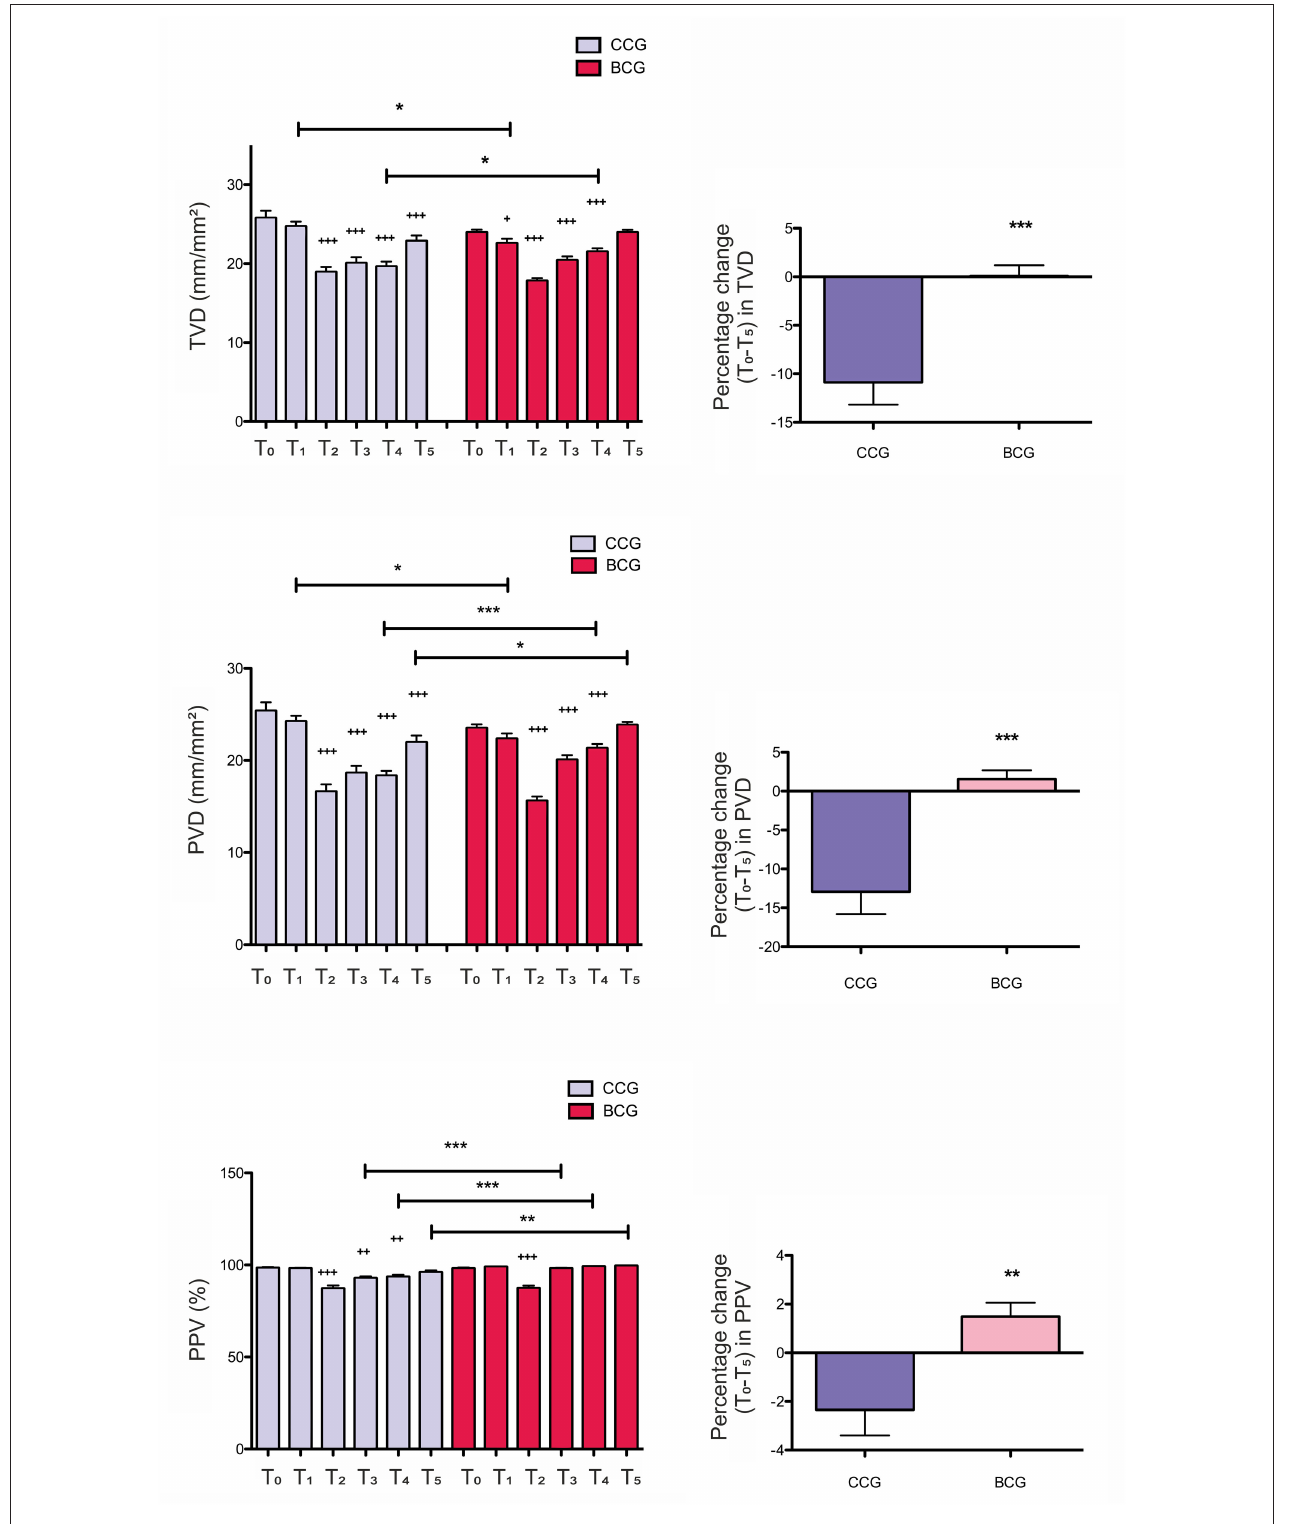
FIGURE 2 | Intraoperative values and related percentage changes of the microcirculatory parameters total vessel density (TVD), perfused vessel density (PVD), and proportion of perfused vessels (PPV) for vessels with a diameter < 20 µ m in the crystalloid cardioplegia (CCG) and blood cardioplegia (BCG) groups. All the values are presented as mean ± SEM. T 0 -T 5 , time points; * p < 0.05, ** p < 0.01, *** p < 0.001 between groups; + p < 0.05, ++ p < 0.01, +++ p < 0.001 vs. T 0 .